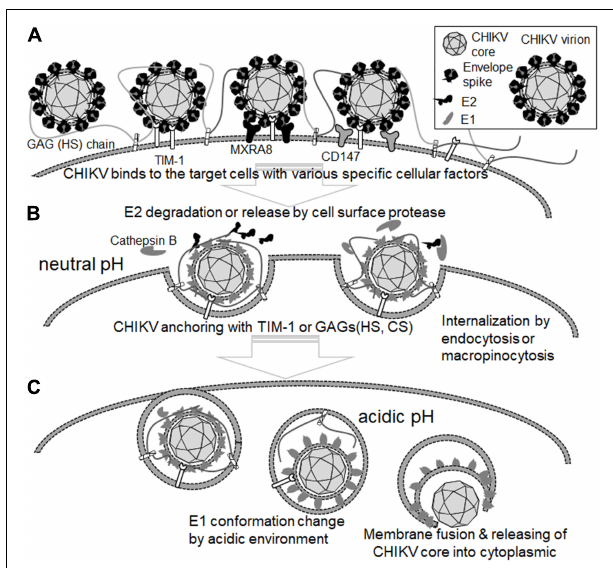
FIGURE 2 | Role of cellular proteins in the attachment and entry steps of CHIKV. (A) CHIKV virion binds to the target cells with cell surface molecules, including HS-proteoglycan, Mxra8, and CD147. (B) E2 is degraded and eliminated from CHIKV virion by cell surface protease such as cathepsin B at the neutral pH. CHIKV virions bearing no E2 are anchored by TIM-1, HS-/CS-proteoglycan, and internalized by endocytosis or micropinocytosis. (C) The conformation of the E1 protein is changed at the acidic pH. Then, the membrane of CHIKV virions and the target cell membrane are fused by the E1 protein, resulting in the release of the CHIKV core into the cytoplasm of the target